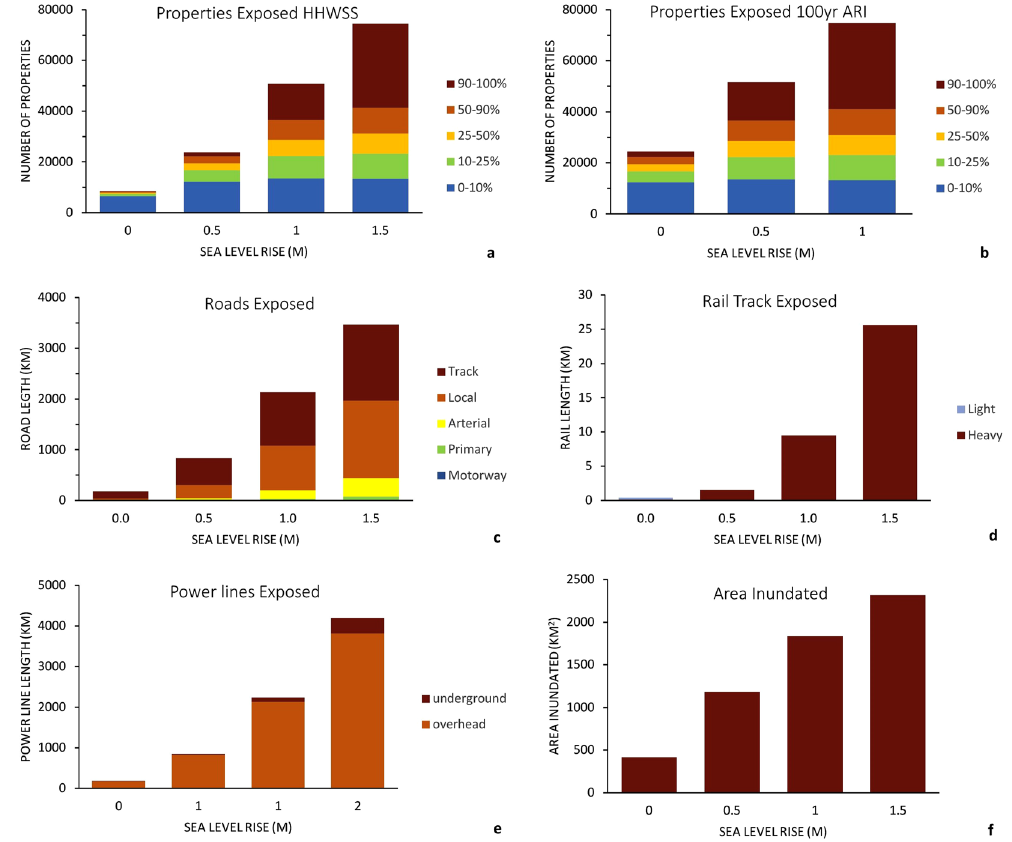
land area inundated (0–10%, 10–25%, 25–50%, 50–90% and 90–100%); ( b ) total numbers of properties exposed to inundation at the 100 yr. ARI level under 0 m, 0.5 m, and 1.0 m sea level rise scenarios including the proportion of property land area inundated (0–10%, 10–25%, 25–50%, 50–90% and 90–100%); ( c ) length of road exposed to inundation (HHWSS or berm level) under 0 m, 0.5 m, 1.0 m and 1.5 m sea level rise scenarios including road type (track, local, arterial, primary or motorway); ( d ) length of rail track exposed to inundation (HHWSS or berm level) under 0 m, 0.5 m, 1.0 m and 1.5 m sea level rise scenarios including track type (light, heavy); ( e ) length of power line exposed to inundation (HHWSS or berm level) under 0 m, 0.5 m, 1.0 m and 1.5 m sea level rise scenarios including line type (underground, overhead); ( f ) overall area inundated (HHWSS or berm level) under 0 m, 0.5 m, 1.0 m and 1.5 m sea level rise